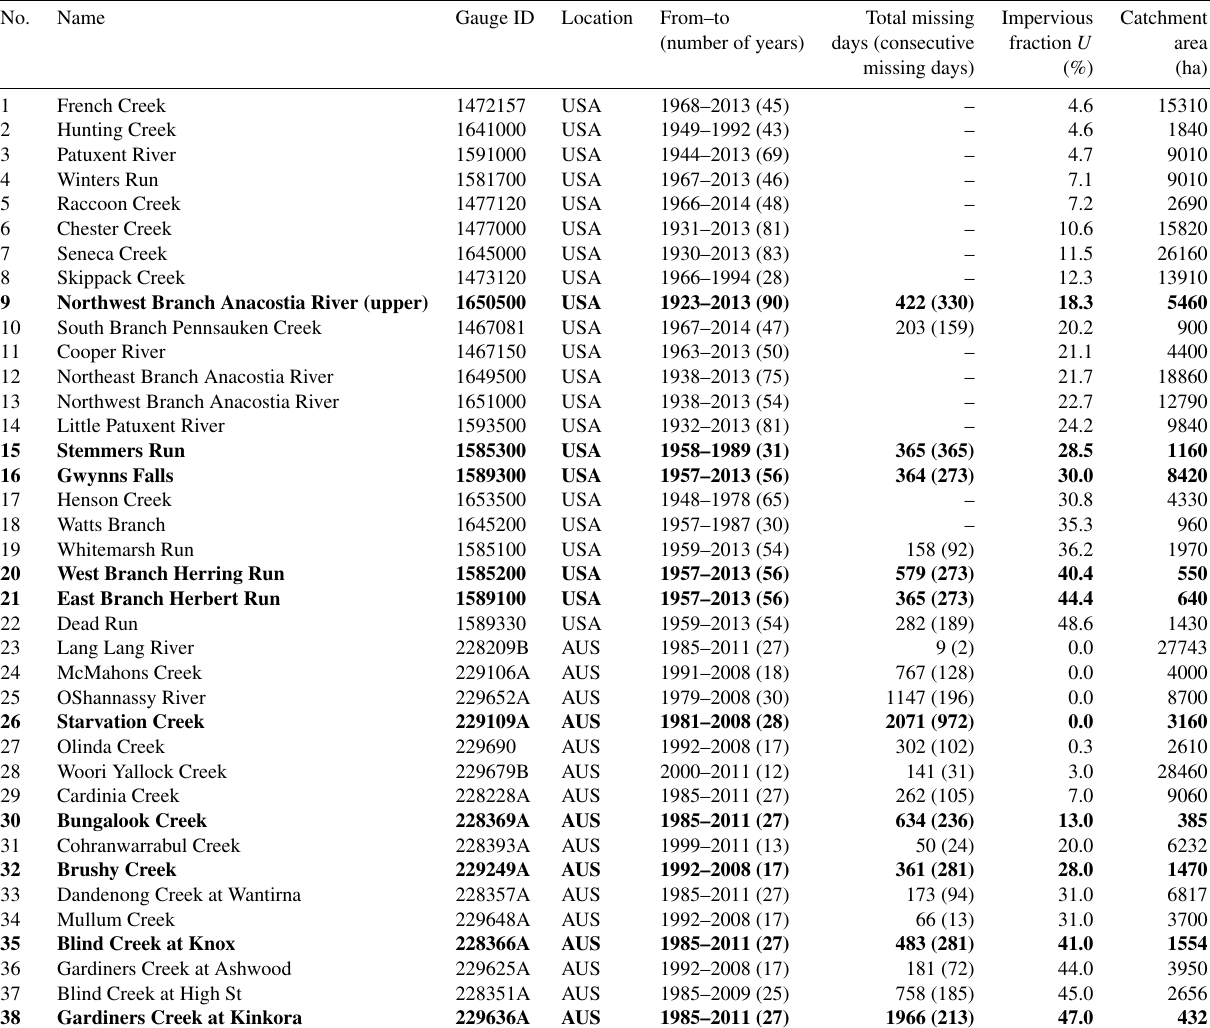
Table 1. US and Australian streamflow monitoring stations with monitoring period, number of missing days, fraction of impervious area and total catchment area. Bold font indicates monitoring stations with gaps in time series longer than 200 consecutive